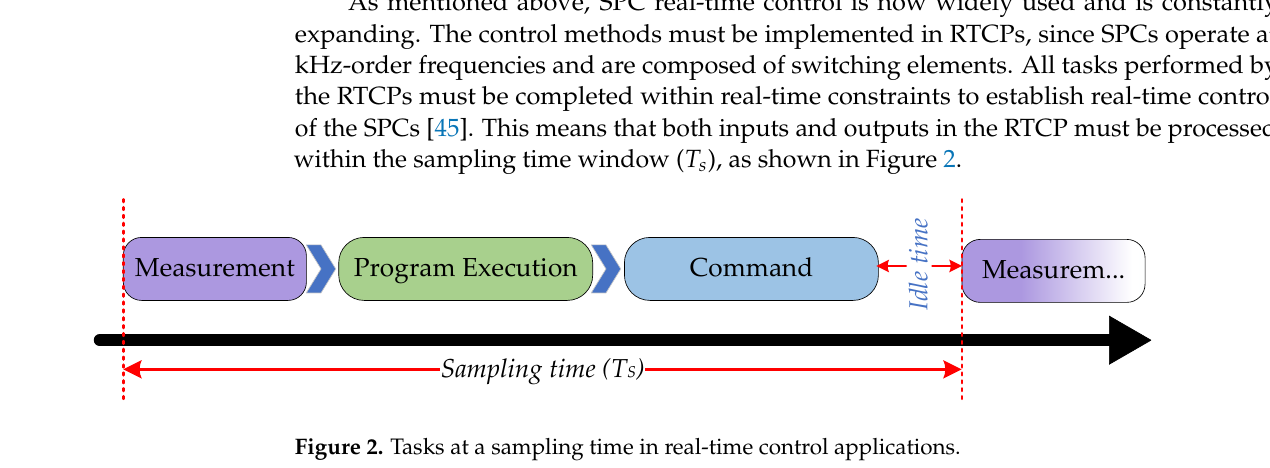
Figure 2. Tasks at a sampling time in real-time control applications.